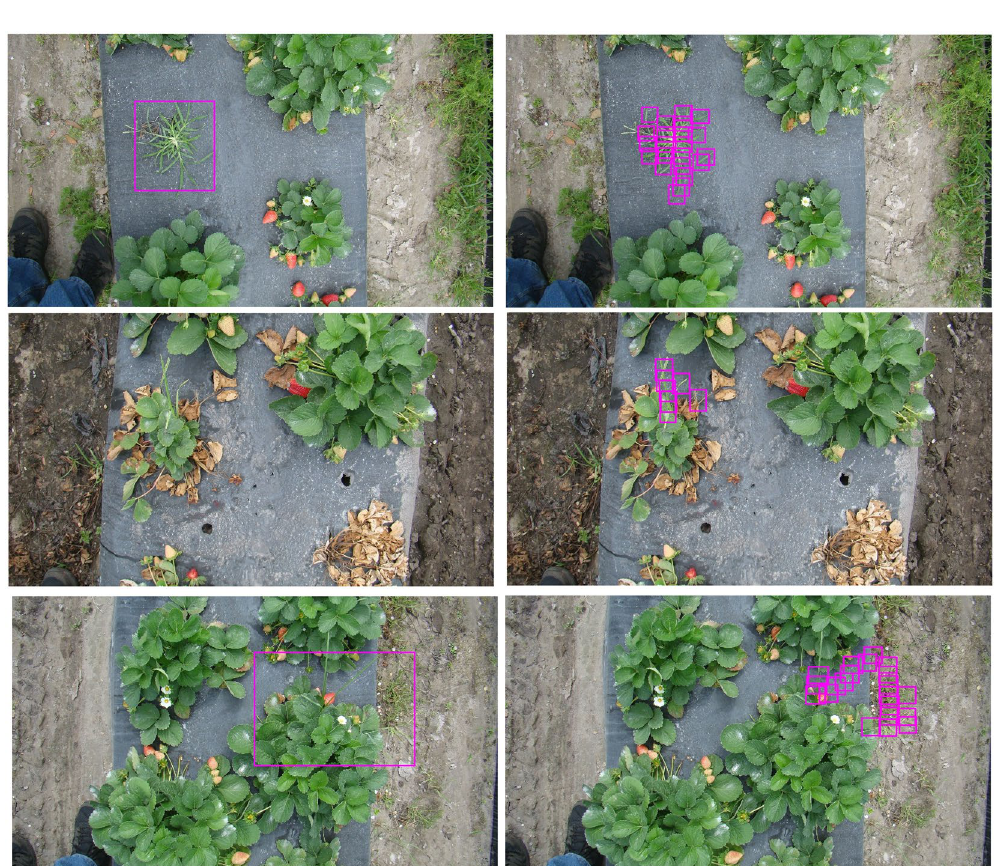
Figure 1. Examples of YOLOv3-tiny network detection of goosegrass ( Eleusine indica ) growing in competition with strawberry ( Fragaria × ananassa ) using either entire plant (left) or leaf blade (right) annotation techniques in Central FL, USA in